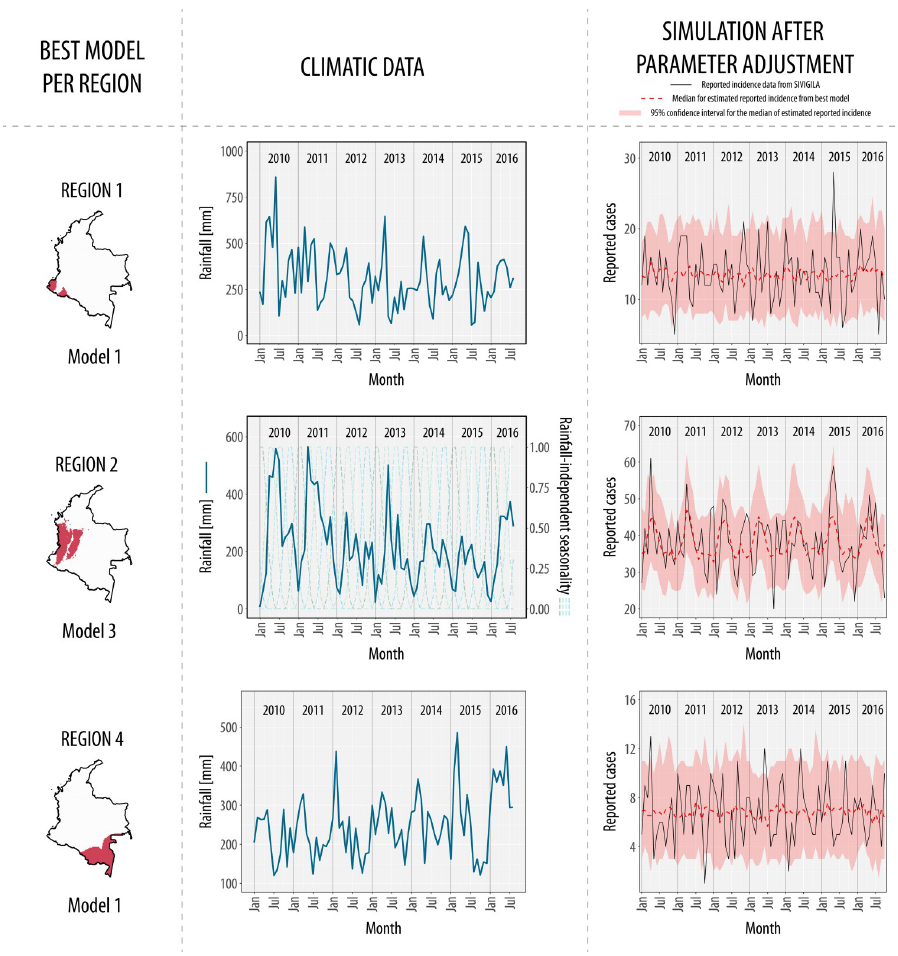
Fig 3. Best models in regions where rainfall does not drive snakebite incidence. Rainfall does not modulate snakebite incidence in three regions of the country, region 1, region 2, and region 4. A rainfall-independent seasonal component (Model 3) modulates snakebite incidence in region 2. This component depends on 4 B-splines (Dashed lines in climatic data plot in region2), not related to rainfall. The best model for regions 1 and 4 was Model 1, where incidence does not have seasonality and is not associated with rainfall. Note the difference between the median of the simulations (dashed red line) for region 2 and regions 1 and 4, wherein region 2 this median has seasonal peaks while in region 1 and 4 is relatively constant. Base map of national boundaries of Colombia was obtained from DIVA-GIS free spatial data (https://www.diva-gis.org/datadown).